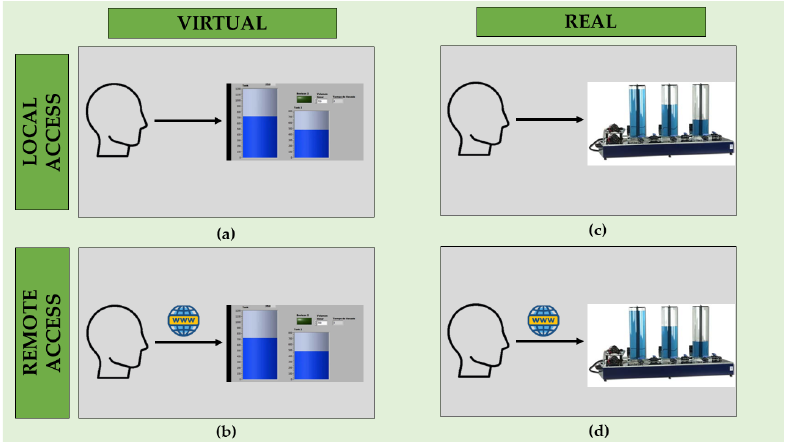
Figure 1. Types of laboratories: ( a ) virtual laboratory with local access; ( b ) virtual laboratory with remote access; ( c ) real laboratory with local access; ( d ) real laboratory with remote access. The main advantages of remote laboratories are